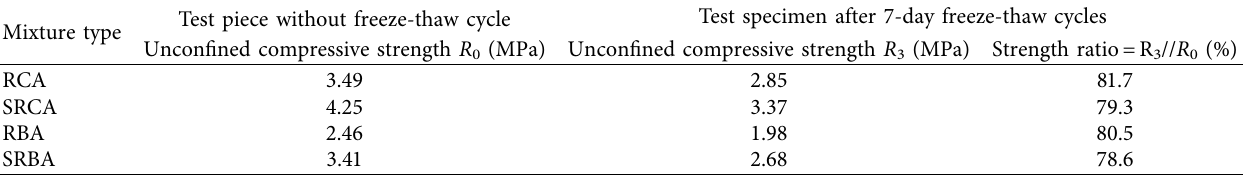
Table 4: Freeze-thaw cycle test